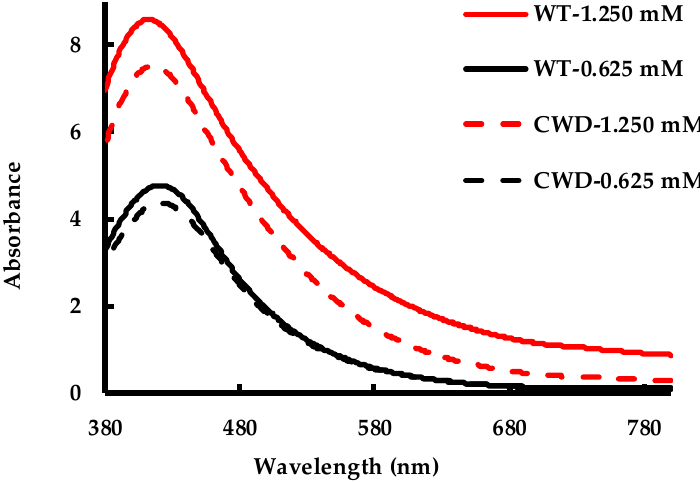
Figure 11. Stability of AgNPs after 10-month storage in the refrigerator.